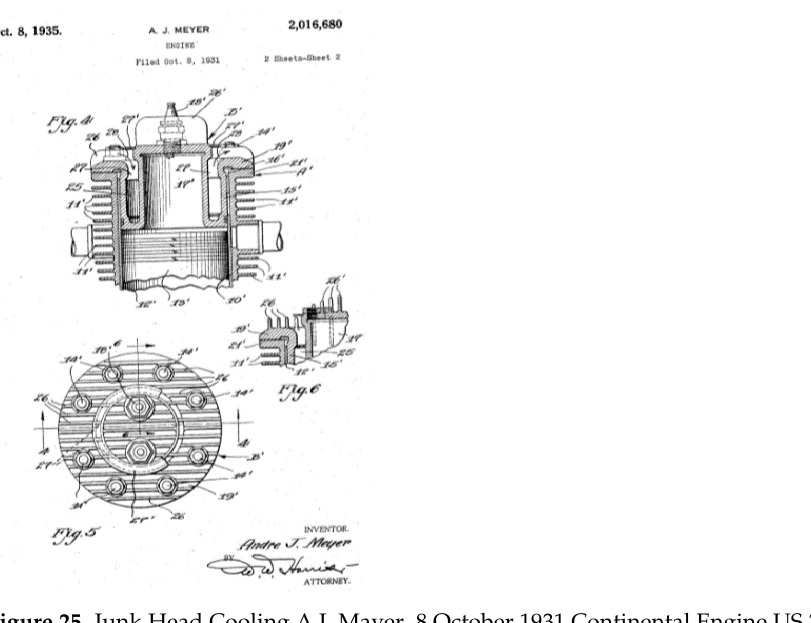
Figure 25. Junk Head Cooling A.J. Mayer. 8 October 1931 Continental Engine US 2016680. Repro-